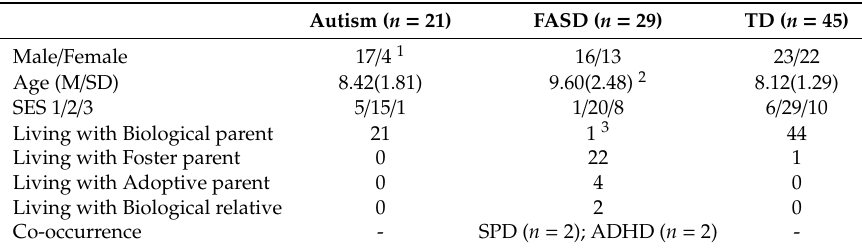
Table 1. Participants.